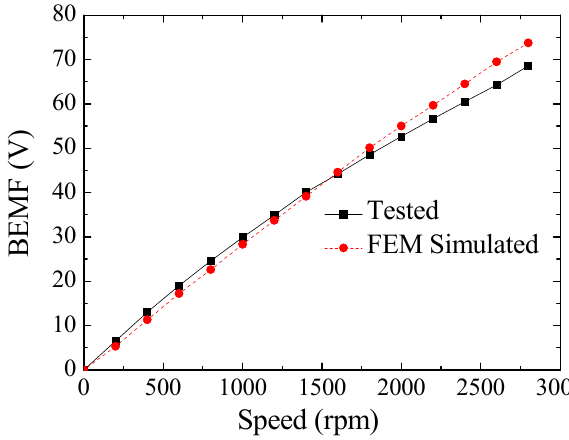
Figure 16. Tested and simulated no-load A-phase BEMFs at different speeds.